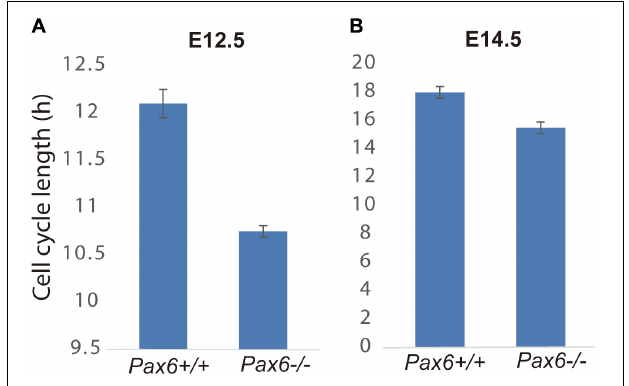
FIGURE 2 | Cell cycle lengths are shortened in Pax6 − / − progenitors. Lengths of the cell cycles of progenitors in Pax6 + / + and Pax6 − / − E12.5 and E14.5 cortex measured using double labeling with IdU and BrdU [ n = 3 embryos of each genotype from three different litters for each age; mean ± SEMs are shown; in panel (A) , p = 0.0099, Student’s t -test; in panel (B) , p = 0.0004, Student’s t